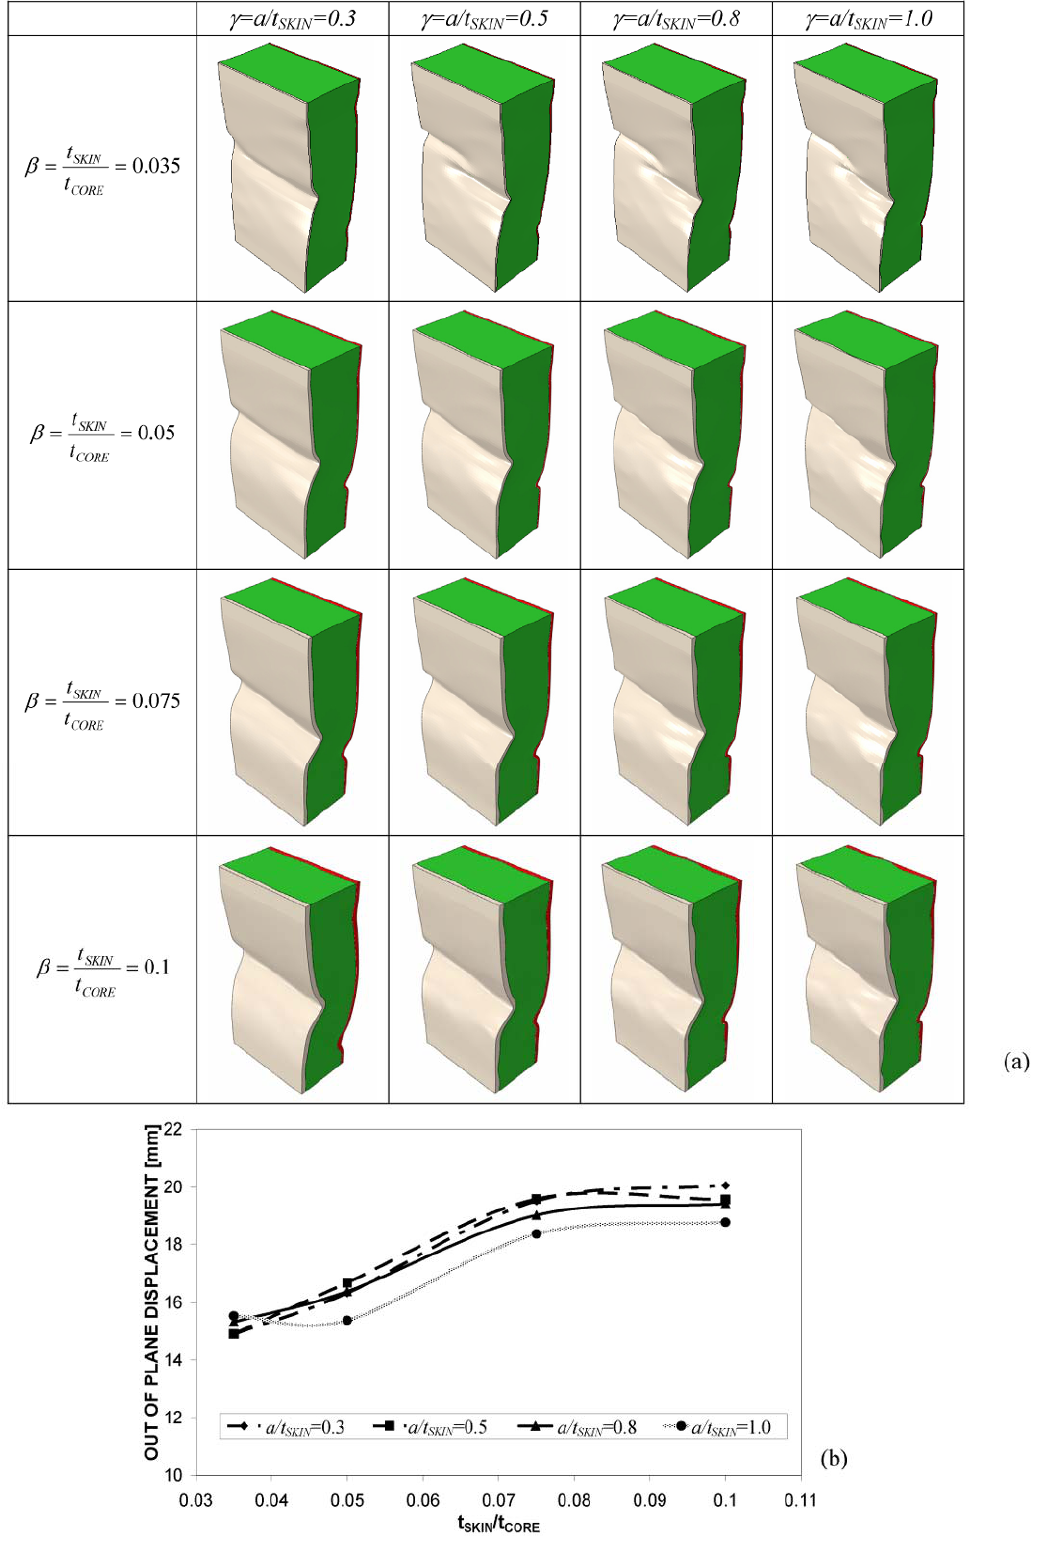
Figure 8. ( a ) Deformed shapes of the foam-based sandwich panel computed by parametric FE analysis for different values of β and γ (skins are colored in grey and red, while the core is colored in green; and ( b ) Variation of total out-of-plane displacement, u to β for each value of γ considered in the parametric